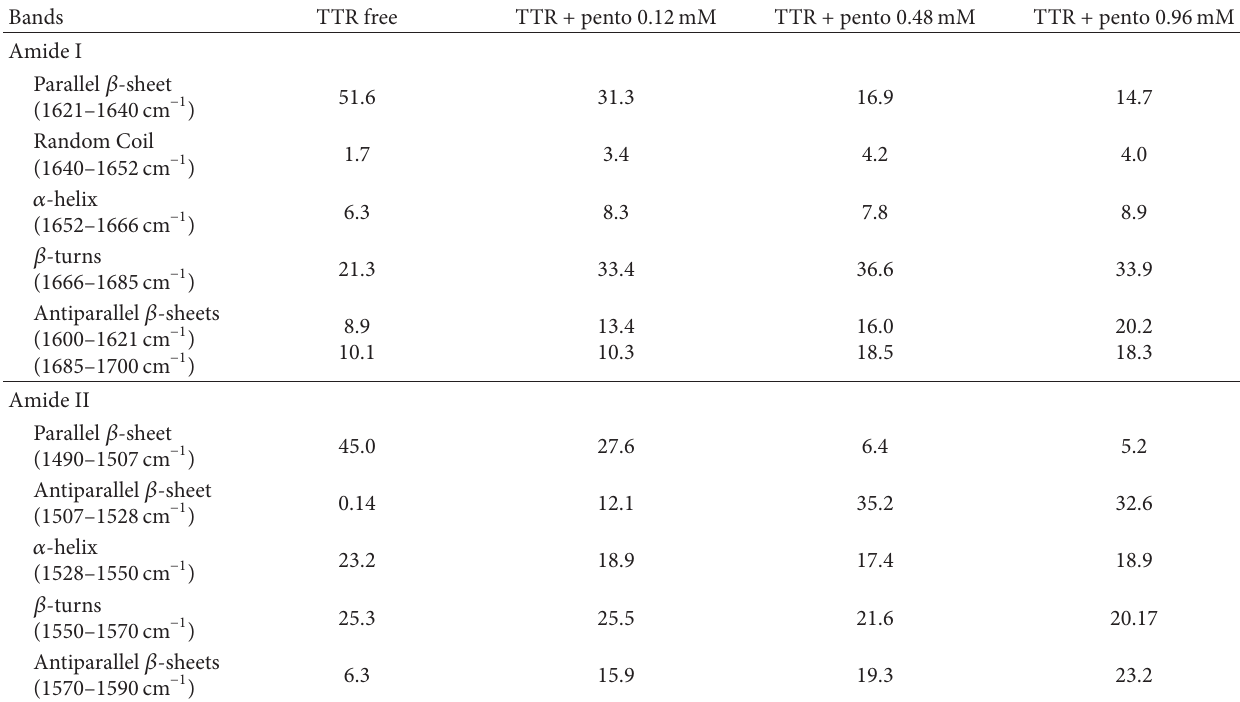
T 2: Percentages of secondary structure components in the amide I and amide II regions of TTR and its pentobarbital complexes.